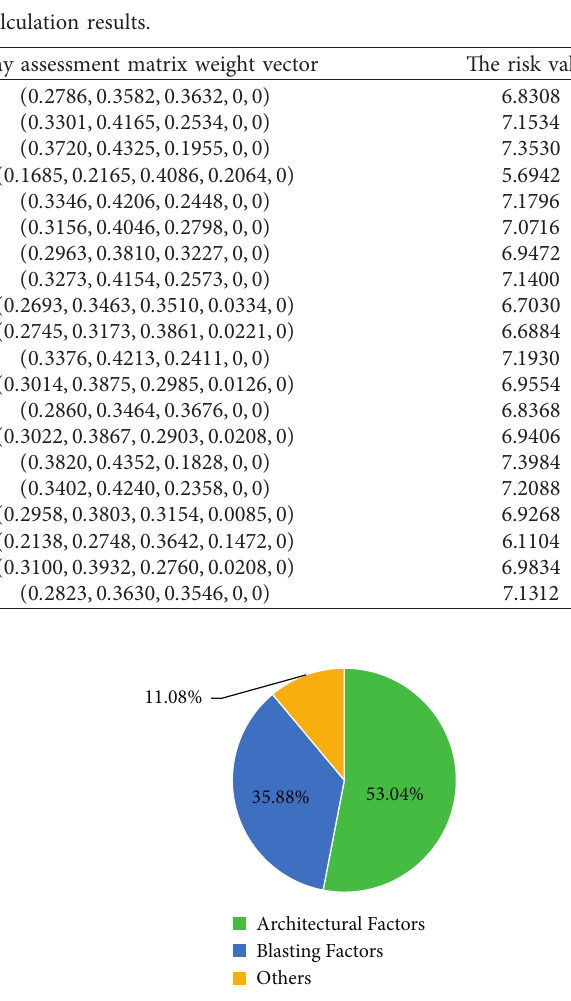
Figure 9: The combined risk weighting for ancient